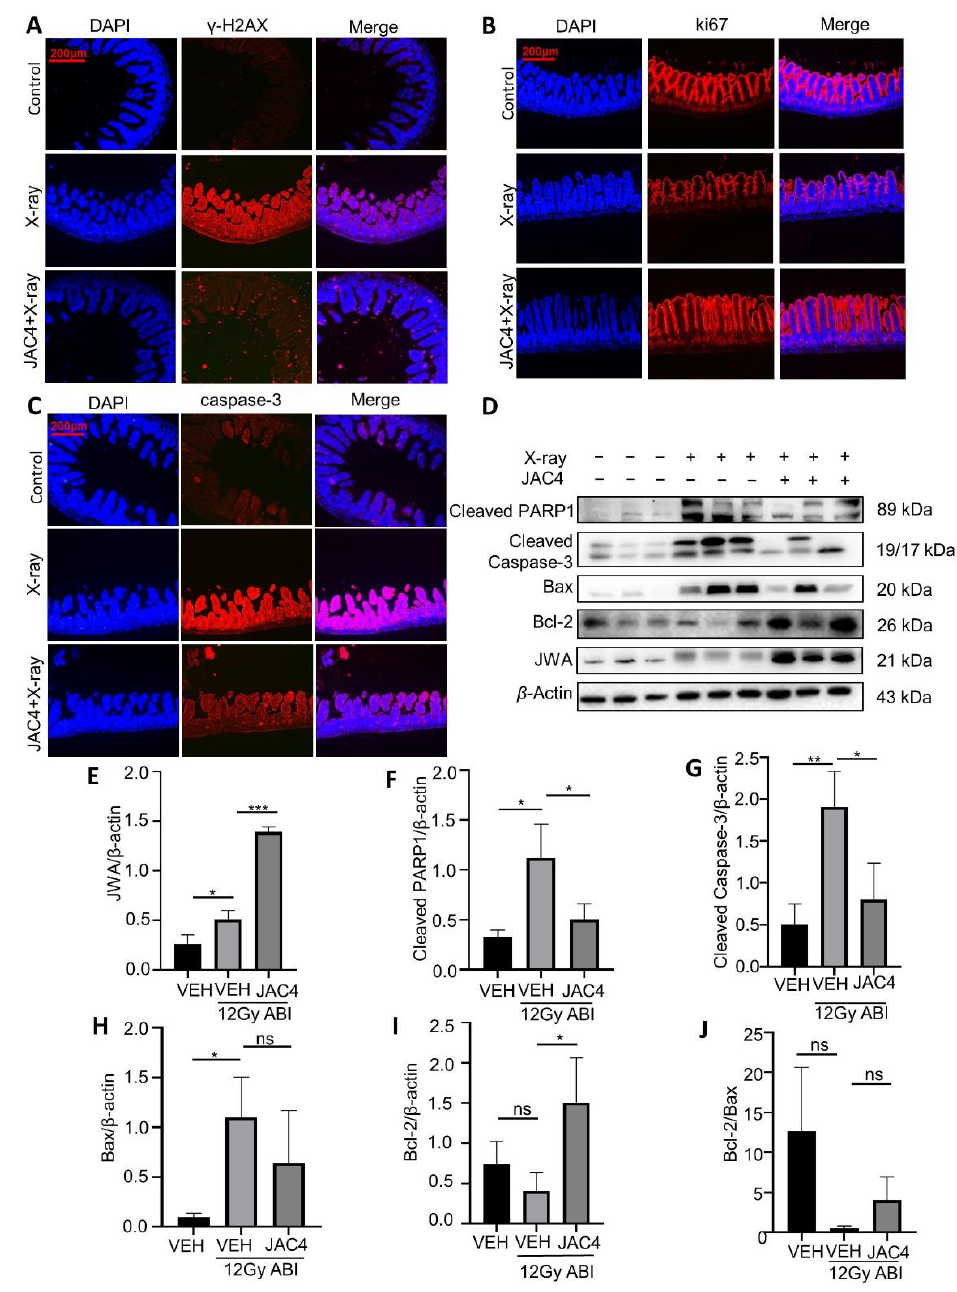
Figure 4. JAC4 attenuates DNA damage and apoptosis of the small intestine after ABI. ( A – C ) Rep- resented images of immunofluorescence staining with γ -H2AX, Ki67, and caspase-3 antibodies in the jejunum on day 4 after ABI. ( D – I ) Protein expression of JWA, cleaved PARP1, Bax, and Bcl-2 in the jejunum after ABI. ( J ) Ratio of Bcl-2 to Bax gray value. Results are presented as mean ± SEM (n = 3) (* p < 0.05; ** p < 0.0; *** p < 0.001; ns: p >